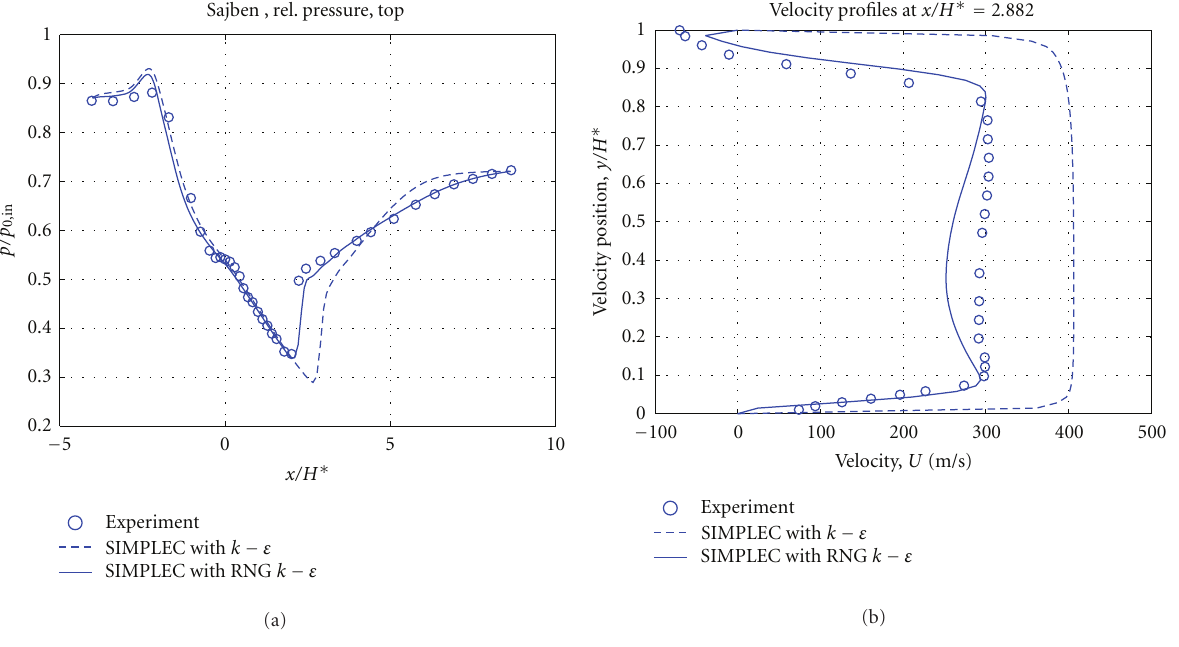
Figure 5: Simulated and measured (a) pressure profile along the top wall of Sajben nozzle, (b) velocity profiles along the vertical monitoring line at a slightly downstream of the vertical shock.